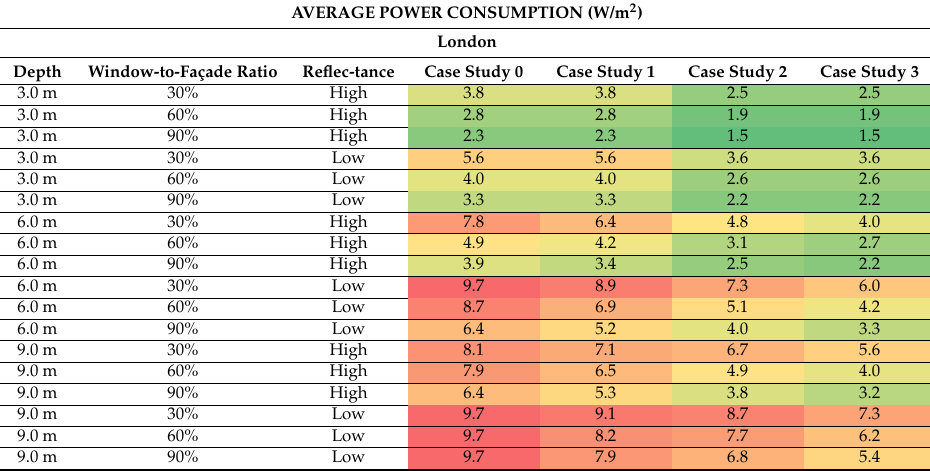
Table 8. Average power consumption in W/m 2 of different lighting smart controls in London.